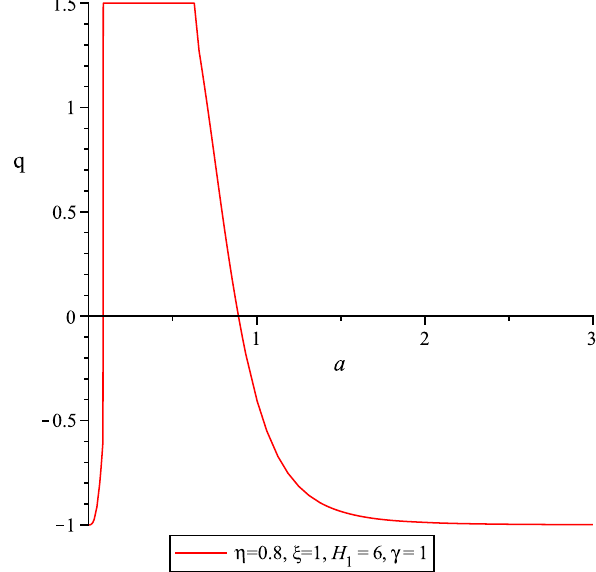
Fig. 1 Shows the evolution of the deceleration parameter against the scale factor a